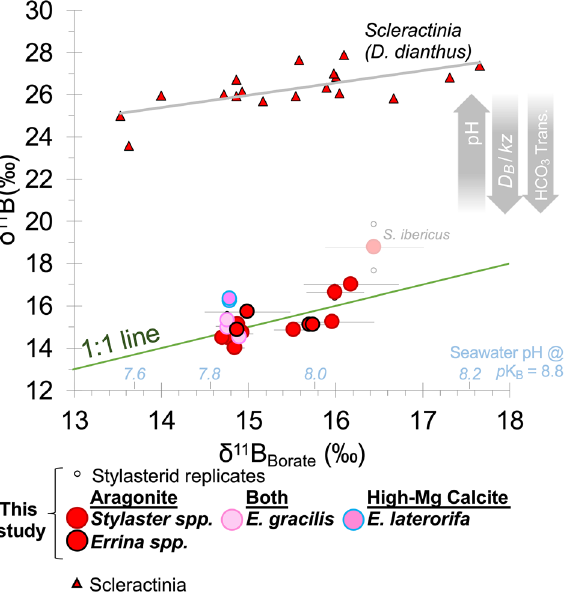
Figure 1. Coral δ 11 B plotted against δ 11 B of the borate ion in seawater (a function of pH; blue labels). Stylasterid corals (circles; this study) are compared to the well-characterised aragonitic scleractinian Desmophyllum dianthus 16,30,31 that strongly upregulate pH at the site of calcification. D. dianthus replicates are averages and one shallow water fjord sample from McCulloch et al. 16 was excluded because of high seawater pH variability at that site. Error bars denote the estimated uncertainty on seawater borate δ 11 B.